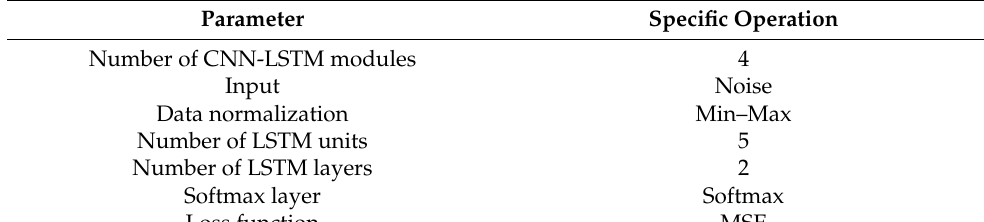
Figure 16. Noise classification based on SE-VMD and CNN-LSTM. Figure 17. Noise denoising based on CNN-LSTM ( − 40 °C −6 0 °C). Table 1. CNN-LSTM specific operating parameters.